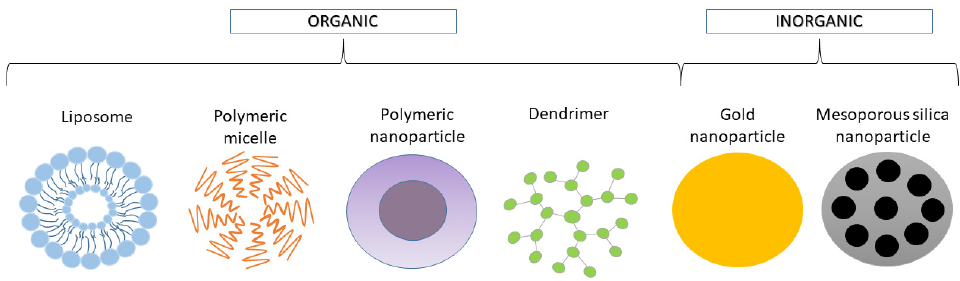
Figure 4. Frequently used types of organic and inorganic